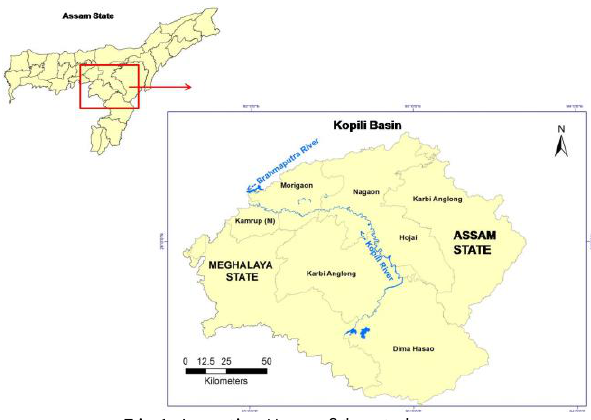
Fig 1: Location Map of the study